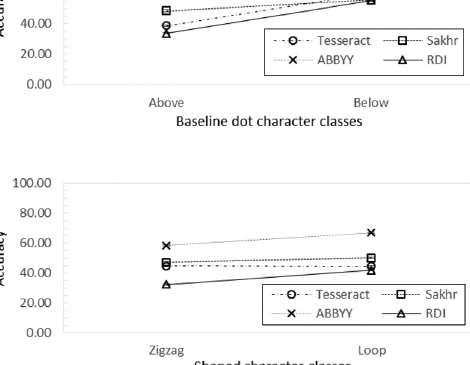
Figure 7. Character